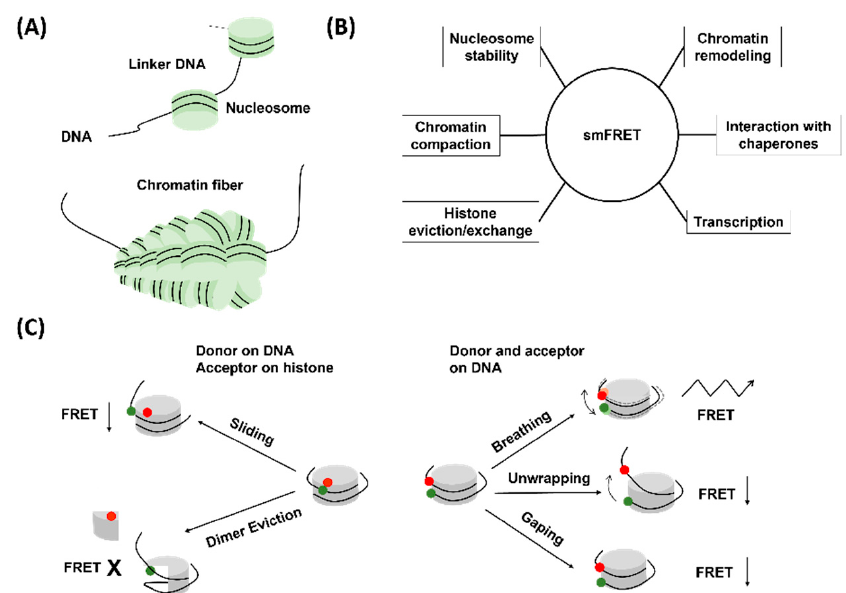
Figure 2. ( A ) Schematic of chromatin structure. ( B ) Different processes studied with smFRET. Research works focused on these processes have been discussed in detail in the main text. ( C ) Different cases of nucleosome structural modification resulting in a change in FRET efficiency. The green and red dots represent the donor and the acceptor dye respectively.